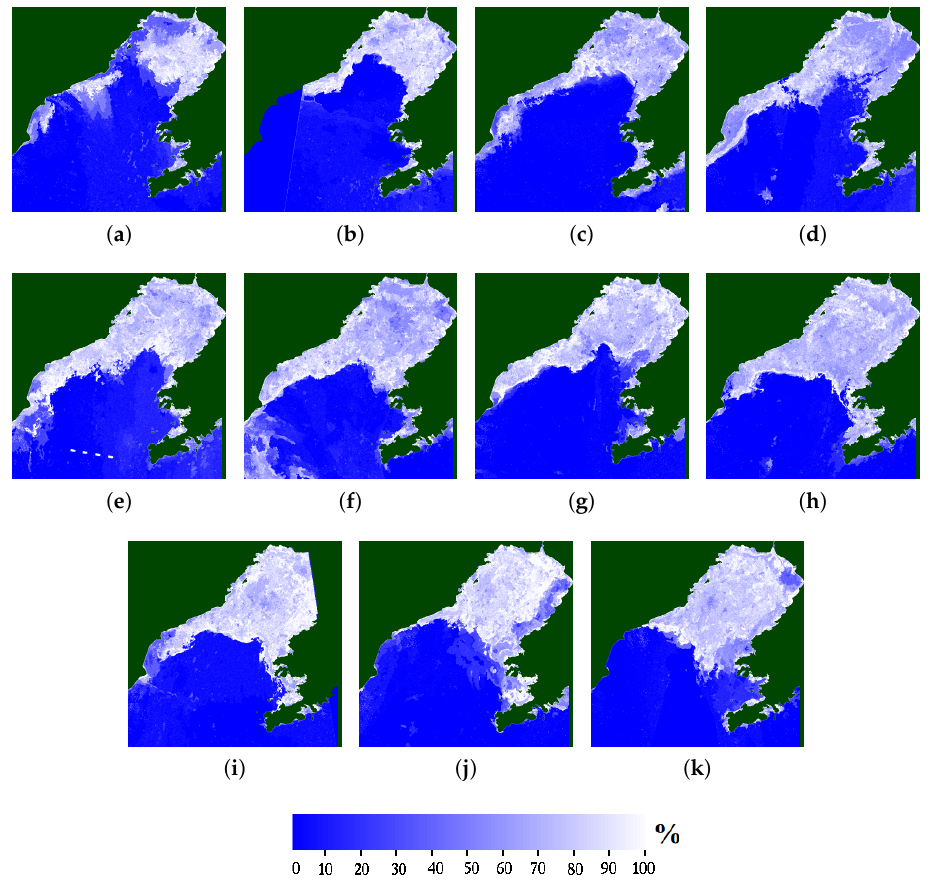
Figure 11. Linear ice concentration estimation results corresponding to the RADARSAT-2 SAR images: ( a ) 2 january 2013; ( b ) 6 January 2013; ( c ) 9 January 2013; ( d ) 16 January 2013; ( e ) 23 January 2013; ( f ) 26 January 2013; ( g ) 2 February 2013; ( h ) 9 February 2013; ( i ) 12 February 2013; ( j ) 16 February 2013; ( k ) 19 February